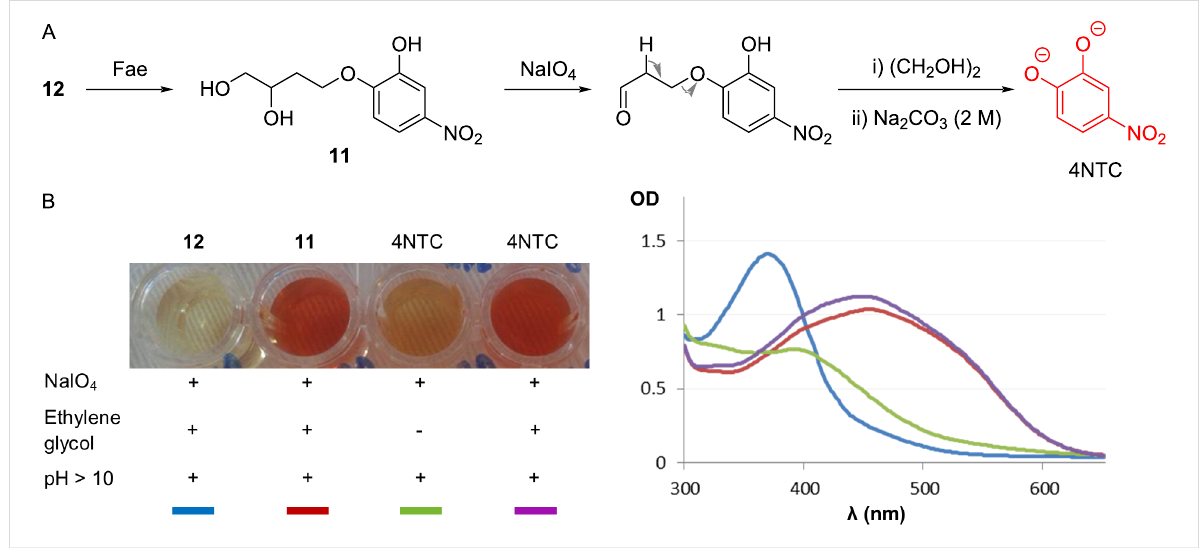
Figure 2: (A) Spectrometric monitoring (at 530 nm) of 4NTC released after the action of Fae on 12 in the presence of sodium periodate and (B) control reactions of the discontinuous assay of the Fae-mediated hydrolysis of 12 . The optical density (OD) was measured during the colorimetric assays. + and − indicate whether the reaction conditions (e.g., pH > 10 or the addition of ethylene) were satisfied in the liquid reaction